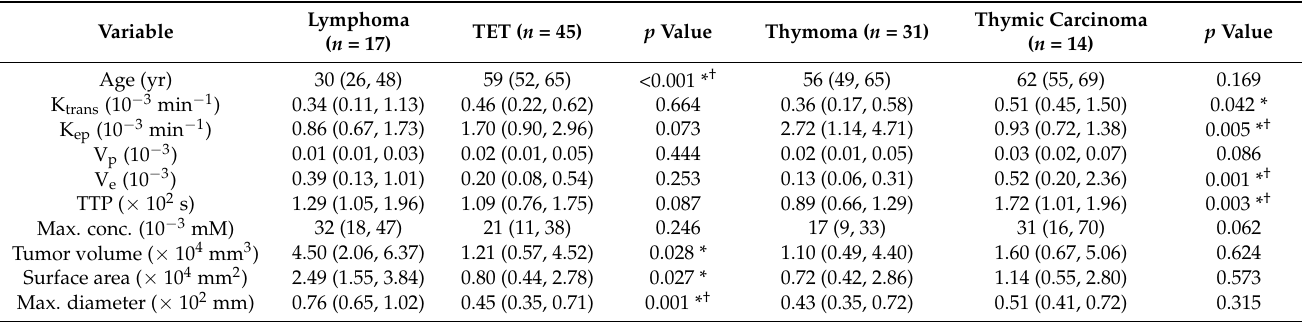
Table 2. Comparisons of age, MR-derived perfusion parameters, and tumor size data between patients with lymphoma and TET and between thymoma and thymic carcinoma.